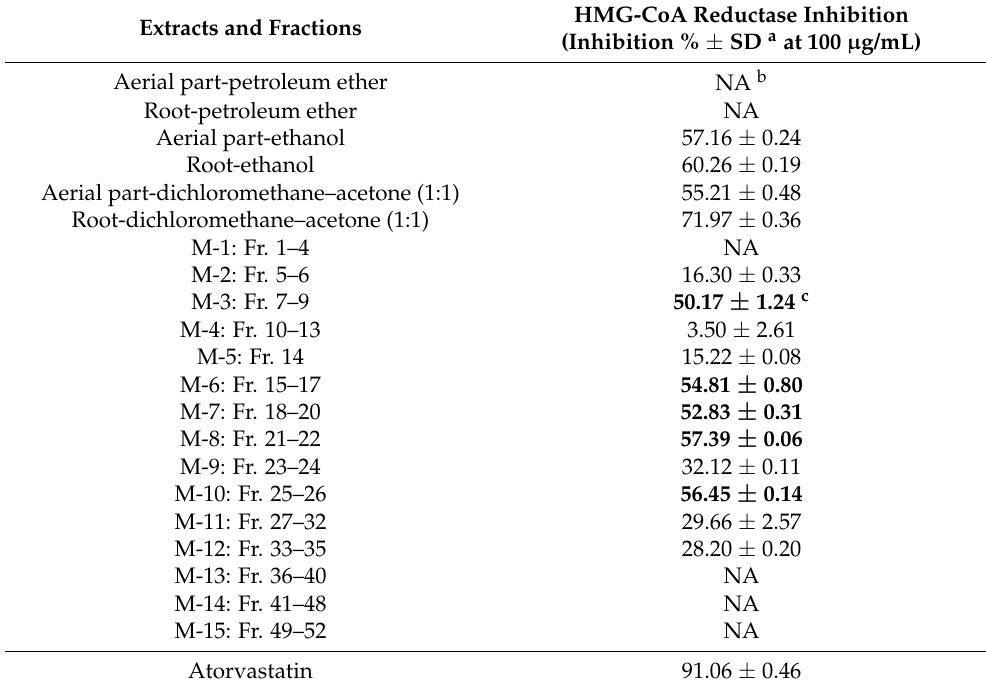
HMG-CoA Reductase Inhibition (Inhibition % ± SD a at 100 µ g/mL)